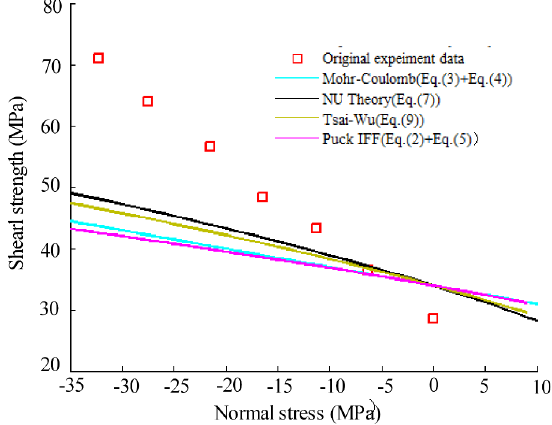
Figure 16: Comparison of original experimental data and failure criteria